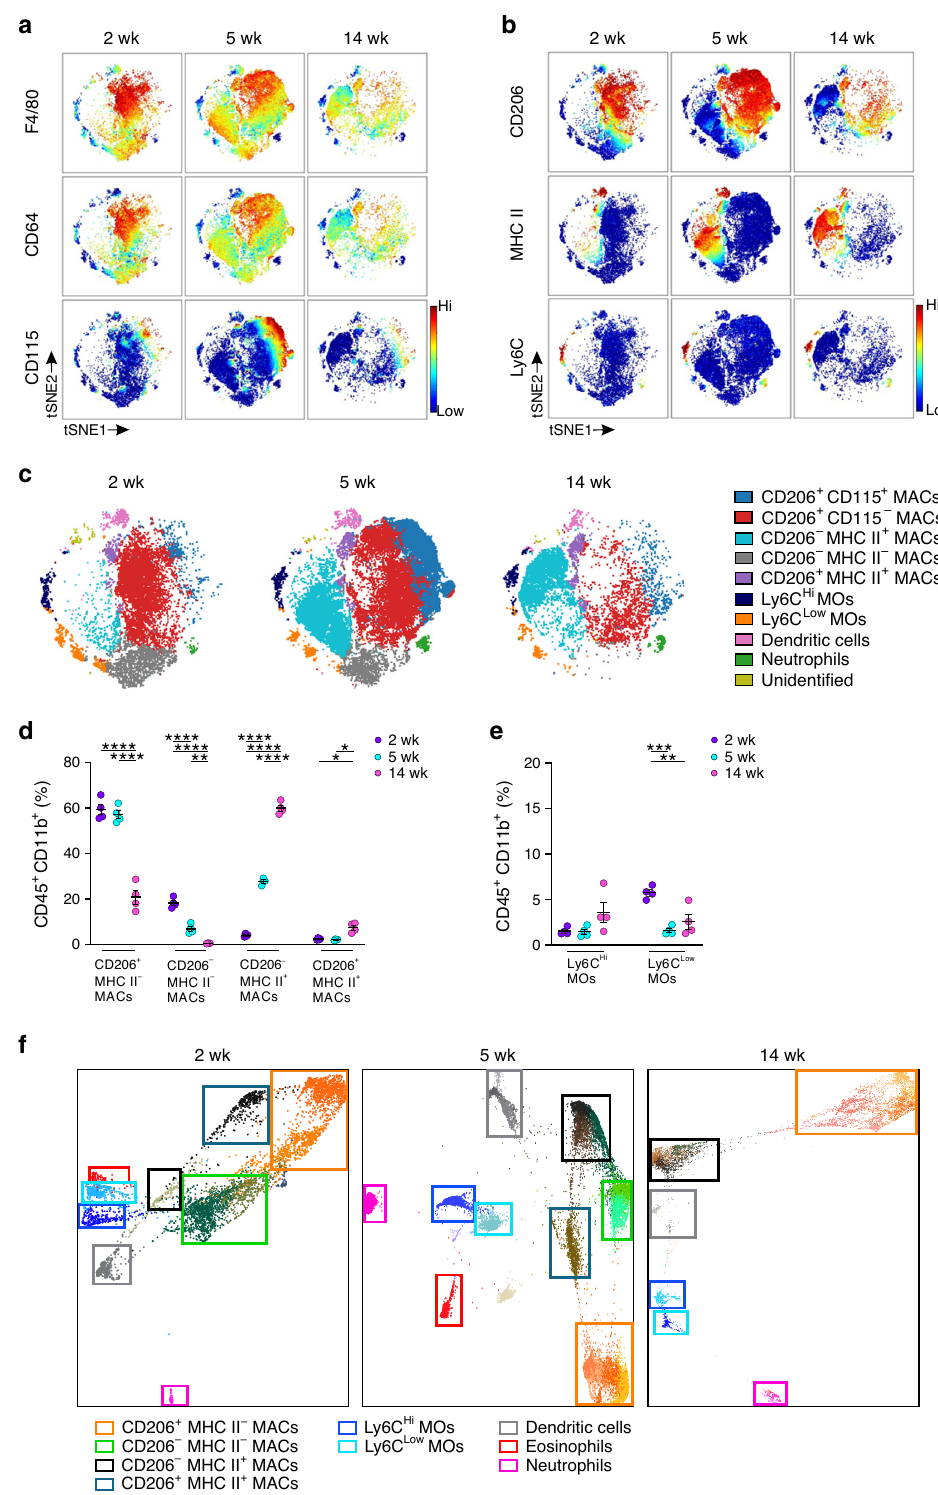
monocyte and macrophage subsets. We fi rst traced yolk-sac- derived macrophages (and their progeny) using the canonical CSF1R Mer − iCre-Mer ;R26R-EYFP reporter mice 42 . When the CSF1R-reporter mice were treated by a single tamoxifen injection at E8.5, the progeny cells were found within F4/80